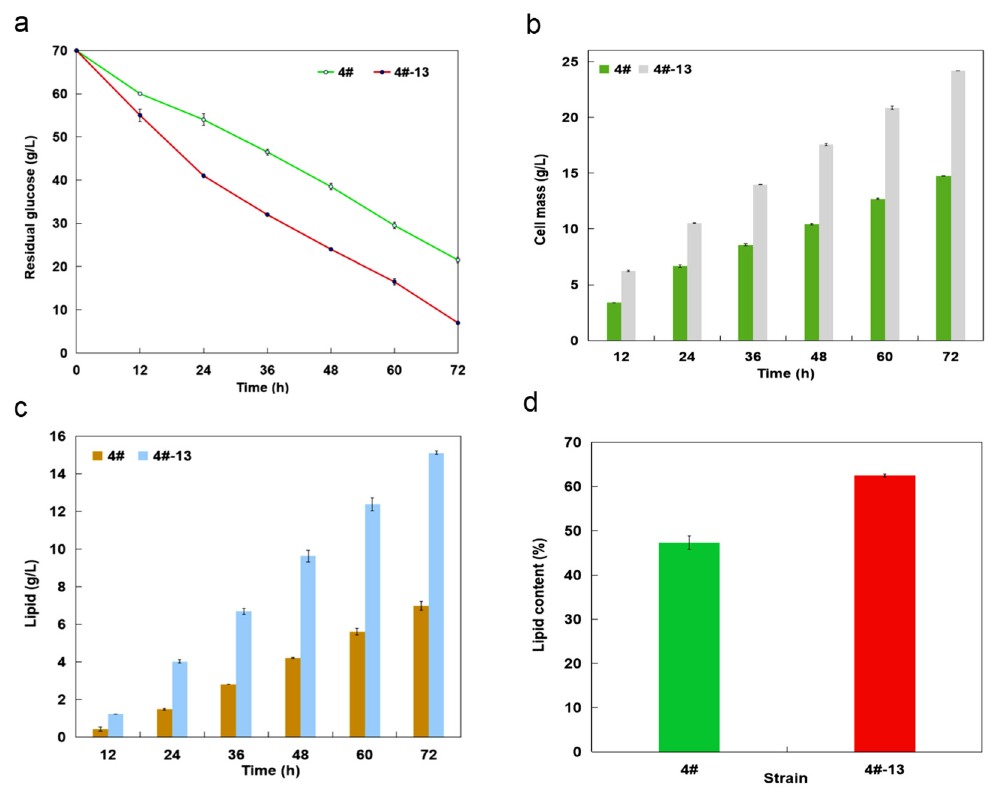
Figure 5. Lipid production in 3 L fermenter at a DO level of 30% by R. toruloides strains. Evolution of ( a ) residual glucose, ( b ) cell mass, and ( c ) lipids. ( d ). Cellular lipid contents. The experiments were done in two technical replicates. Data are means ±SD of two replicates.